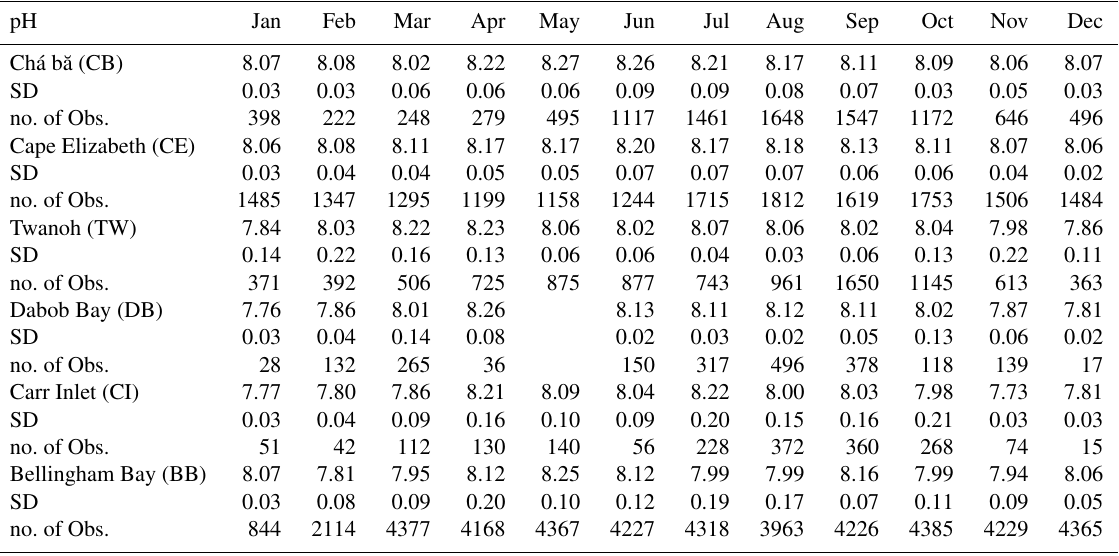
Table C6. Average monthly pH seasonal cycles for the six Washington State moorings with pH sensors or sufficient observations to estimate pH. The average monthly standard deviation (SD) and total number of observations (no. of Obs.) contributing to the monthly average estimate are included.